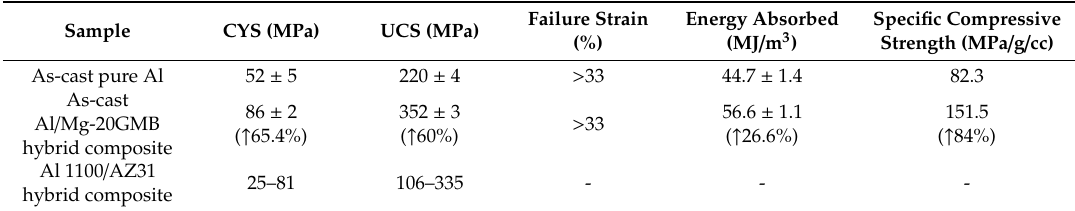
Figure 6. ( a ) Stress-strain curves for as-cast pure Al and Al / Mg-20GMB hybrid composite under compression loading. ( b , c ) The corresponding picture of fracture specimen after compression. Table 3. Compression properties of as-cast pure Al and Al / Mg-20GMB hybrid composite.